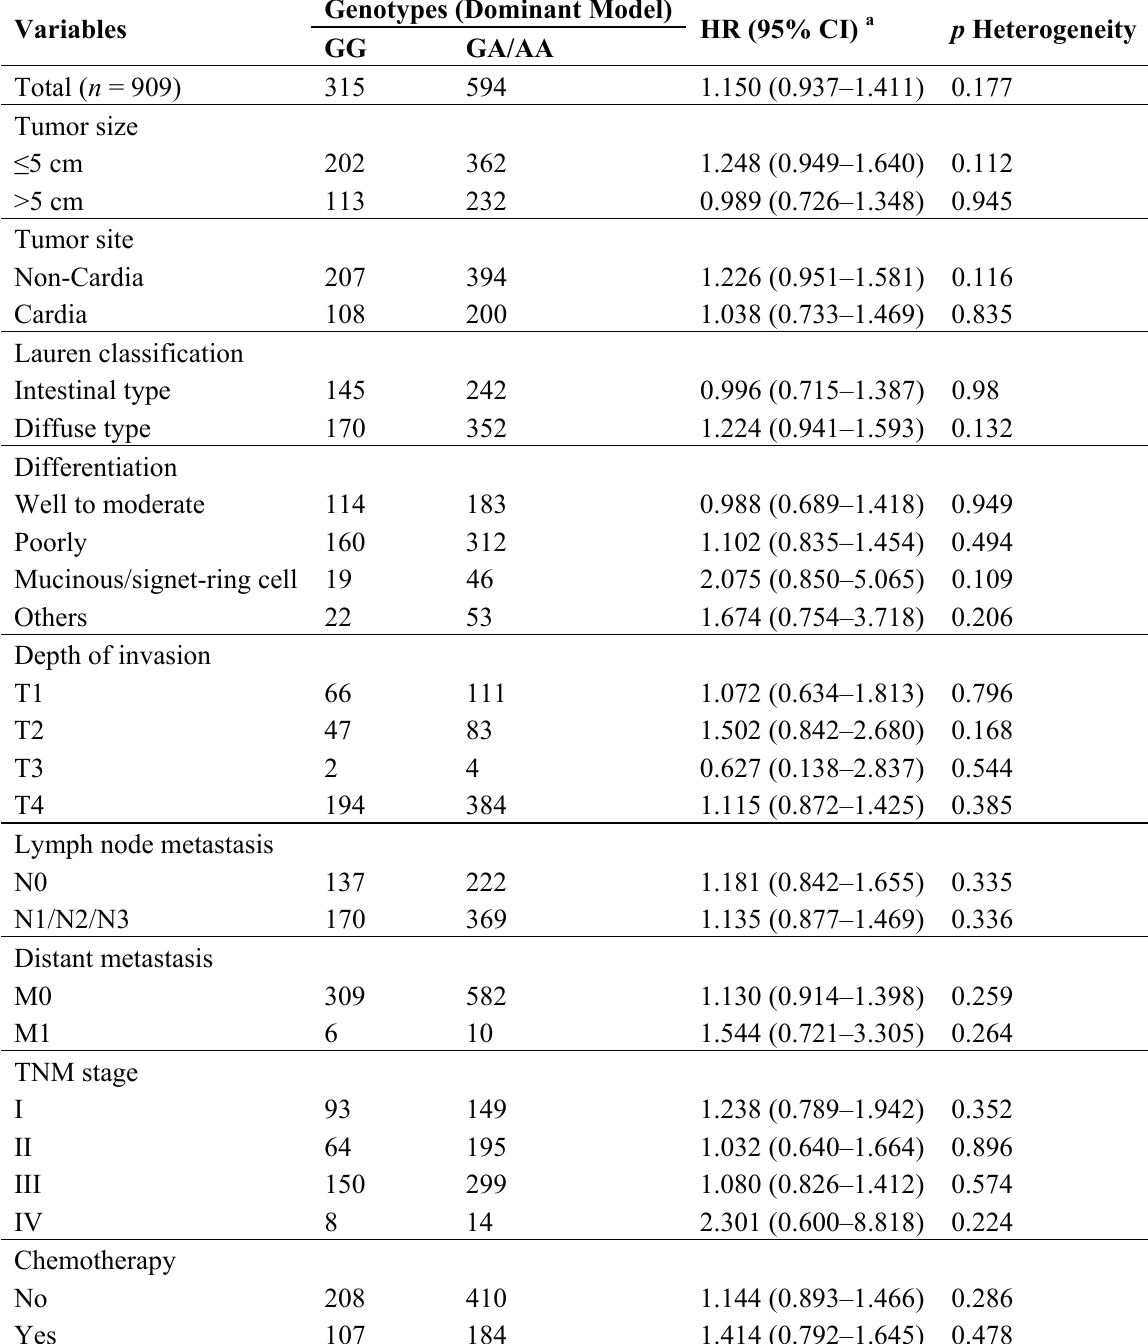
Table 3. Stratified analysis of association between rs10505477 polymorphism and overall survival of gastric